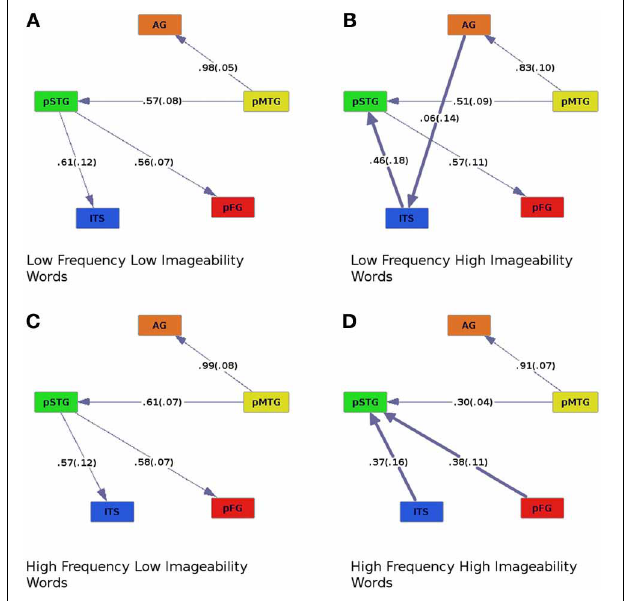
FIGURE 2 | Effective connectivity results for high (C,D) and low (A,B) levels of spelling-sound consistency crossed with high (B,D) and low (A,C) levels of imageability. Colors correspond to Figure 1 . Numbers along connections represent model regression fit coefficients averaged across participants, with standard errors in parentheses.